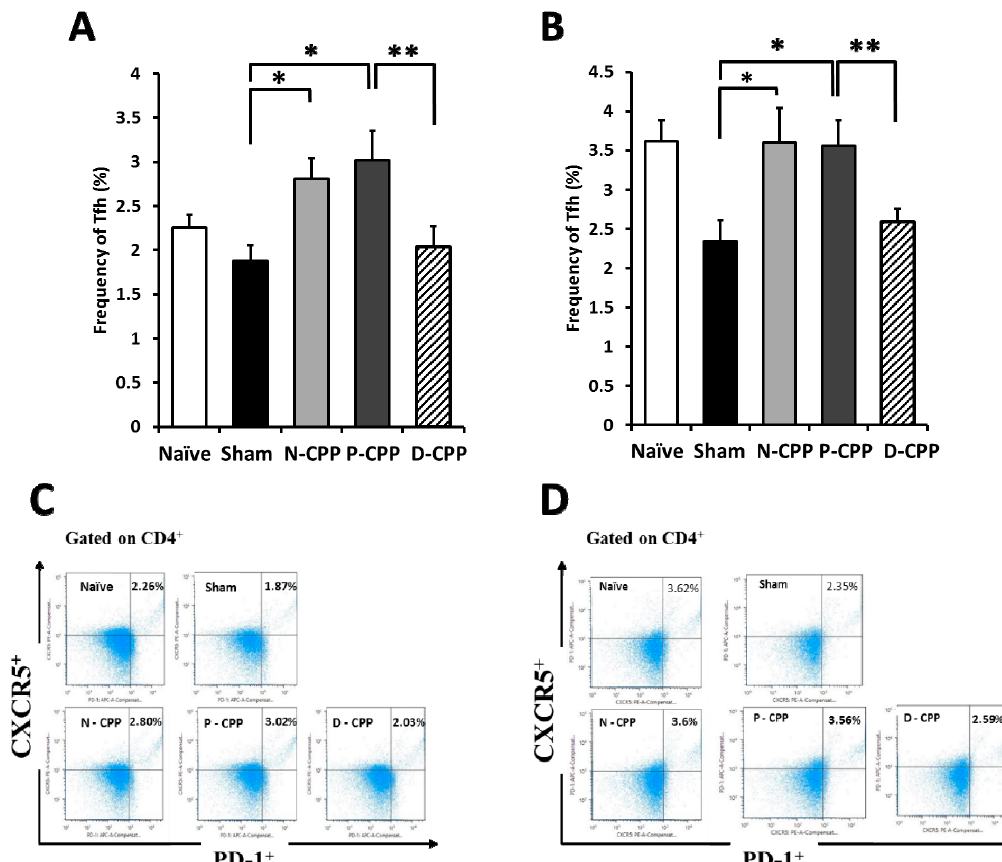
Figure 6. Effects of oral feeding with differently phosphorylated CPP-III on T follicular helper (Tfh) cell population. Percentage of Tfh cell populations in cultured SP ( A ) and PP ( B ). Representative FACS staining for SP ( C ) and PP ( D ). Cells harvested from OVA-sensitized mice were determined by flow cytometry without stimulation with OVA. Data represent the mean ± SE of individual mice in the group. * p < 0.05; ** p < 0.01 and dots represent cell proliferation.